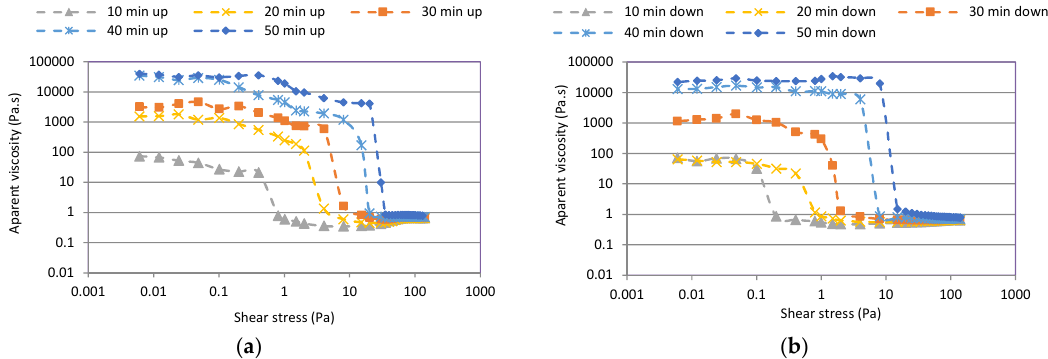
Figure 6. Curves obtained from the shear stress ramp for grout with 0.03% PP fibers: ( a ) up curves ( b ) down curves.